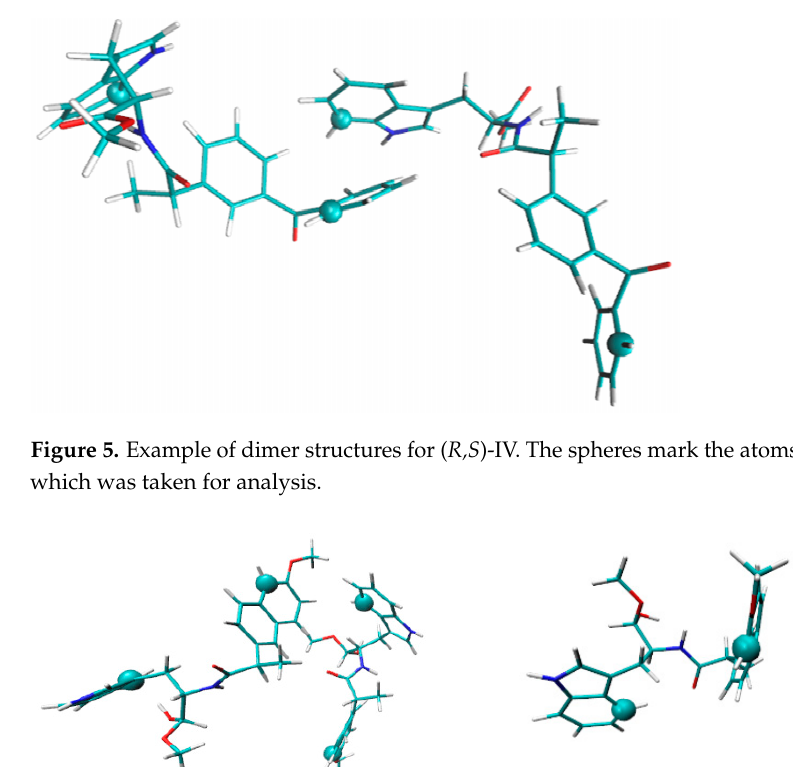
Figure 4. Snapshots of MD trajectories for ( a ) ( S,R )-IV and ( b ) ( R,S )-IV illustrating different mutual orientation of ketoprofen aromatic rings.